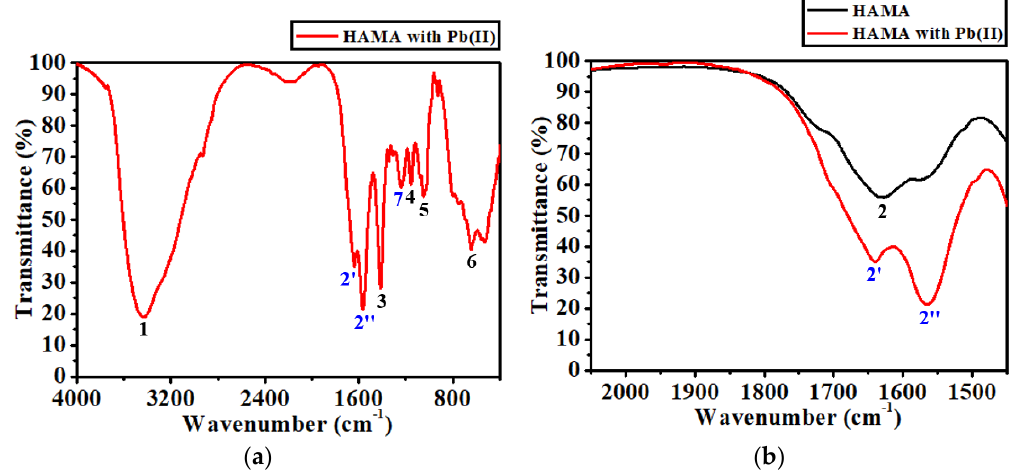
Figure 6. ( a ) FTIR spectrum of the HAMA hydrogel soaked in a solution of 100 µg/L Pb(II), in which the numbers 2 ′ , 2 ″ , 7 (in blue) denote the new peaks. ( b ) Comparison of FTIR spectra in a frequency band from 2050 to 1450 cm − 1 between the pure HAMA hydrogel and the one soaked in Pb(II) solution. Table 1. Comparison of peak positions in terms of wavenumber (cm − 1 ) between the pure HAMA hydrogel and the Pb(II)-soaked HAMA